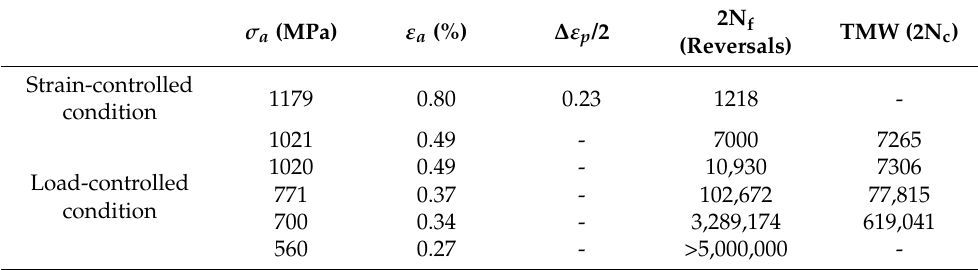
Table 5. Fatigue test results of HIPed LB-PBF 17-4 PH stainless steel with the machined surface under axial loading (test information and data taken from